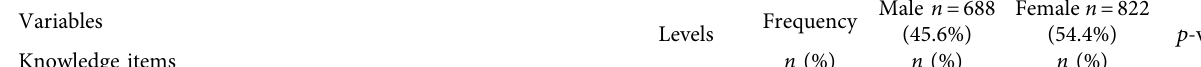
Table 2: Knowledge and attitude towards physical activity among 1500 adolescents in the KSA by gender.